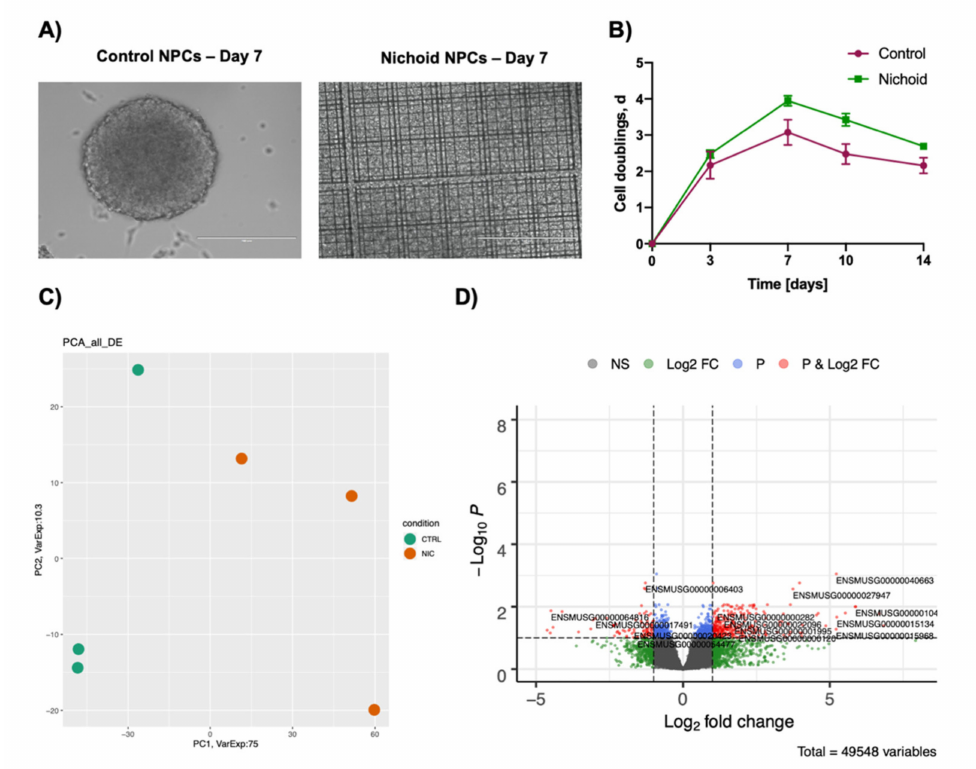
Figure 1. Neural precursors cells grown inside the Nichoid present with di ff erent morphology and transcription profiles. ( A ) In vivo direct light images (EVOS FL microscope, EuroClone) of NPCs neurospheres maintained in stem cells medium in standard floating conditions (control NPCs) or grown inside the Nichoid (Nichoid NPCs) at day 7. Scale bar: 200 µ m. Images are representative of what was observed in more than 10 experiments. ( B ) Cell doublings were calculated after proliferation assay was performed by plating 10,000 NPCs either in standard floating condition or inside the Nichoid. Cells were counted and collected after 3, 7, 10, and 14 days in two experiments ( n = 2). ( C ) For RNA-Seq, three samples for condition were analyzed ( n = 3). Specifically, three experiments were performed each including one sample of NPCs grown in standard floating conditions for 7 days and one sample of NPCs grown inside the Nichoid for 7 days. The graph shows the principal component analysis (PCA) of di ff erently expressed genes in NPCs grown on the Nichoid and in standard conditions. We considered as di ff erentially expressed only genes showing | log 2 (Nichoid samples / control samples) | ≥ 1 and a false discovery rate ≤ 0.1. ( D ) Volcano plot showing deregulated genes between NPCs grown on the Nichoid and in standard conditions. Table 1. Number of deregulated coding and noncoding RNAs after transcriptome analysis. CTR vs.